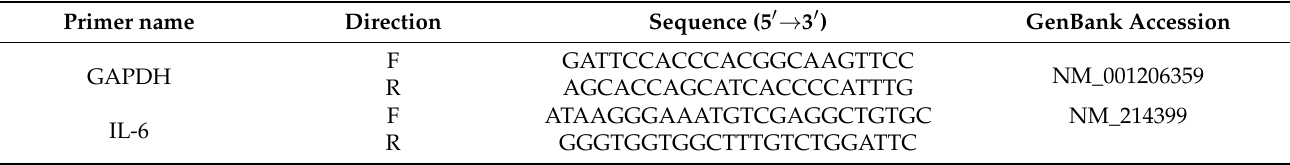
Table 1. Real-time PCR primers used in porcine samples.